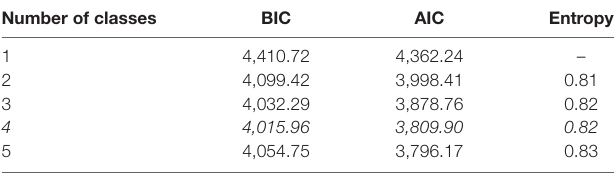
TABLE 1 | Model fit and precision of latent class solutions with one to five